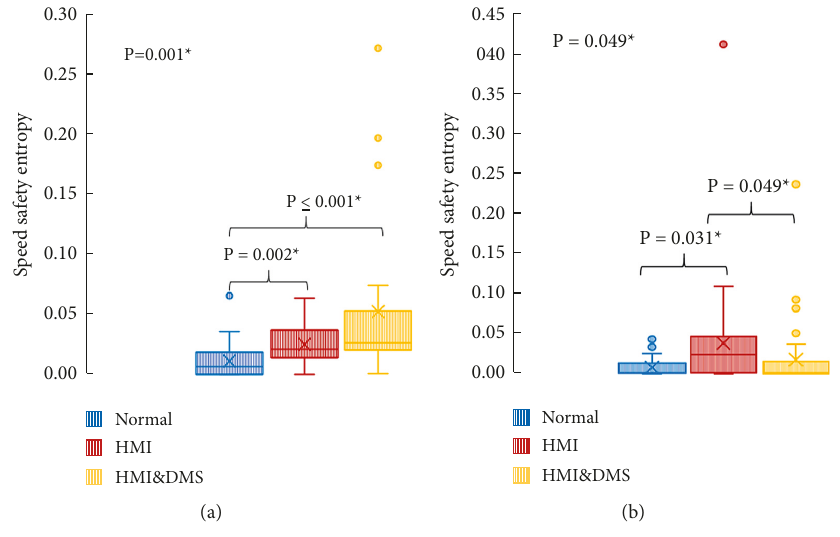
Figure 6: Speed safety entropy. (a) Clear zone. (b) Fog zone.